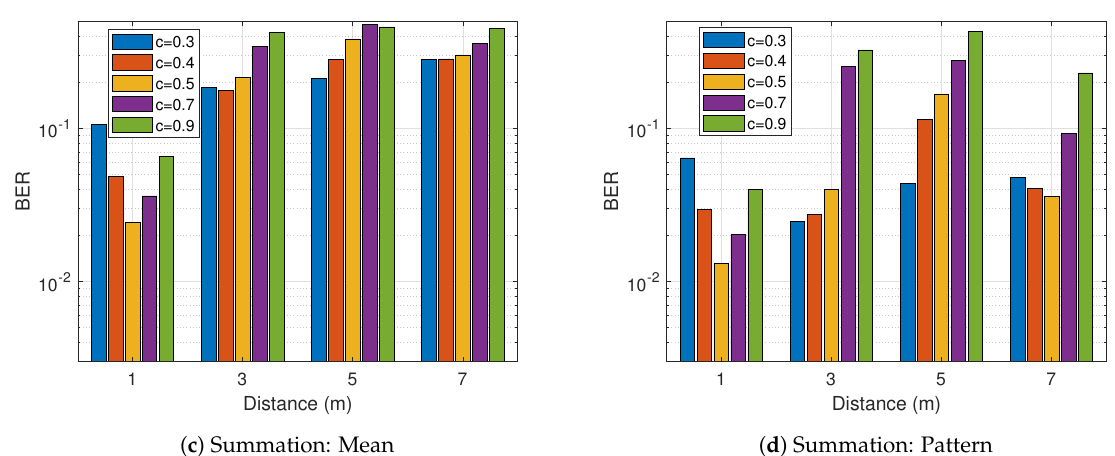
Figure 8. Experimental results for different threshold constant c with sliding and pattern-based decoding.